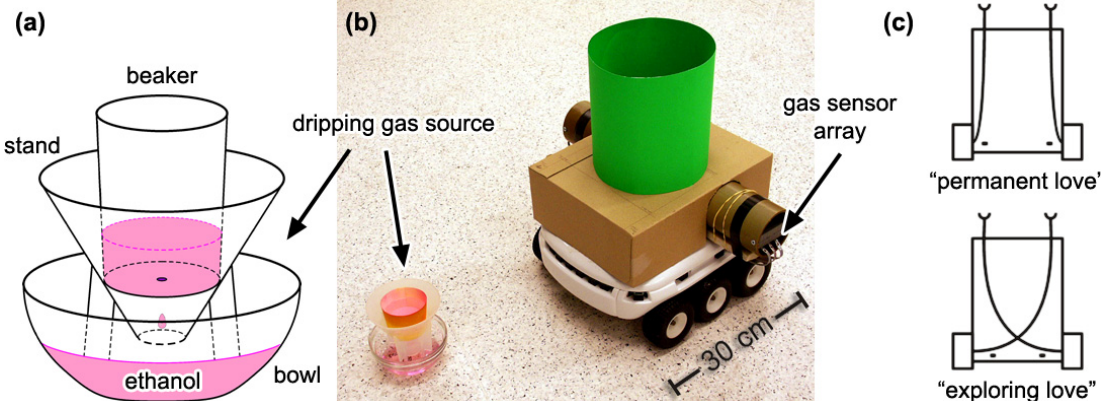
Figure 18 . (a) Sketch of the gas source. (b) Koala robot with the ¨Orebro Mark III mobile nose in front of the dripping gas source. (c) Schematic view of the direct (inhibitory) sensor-motor coupling (Braitenberg